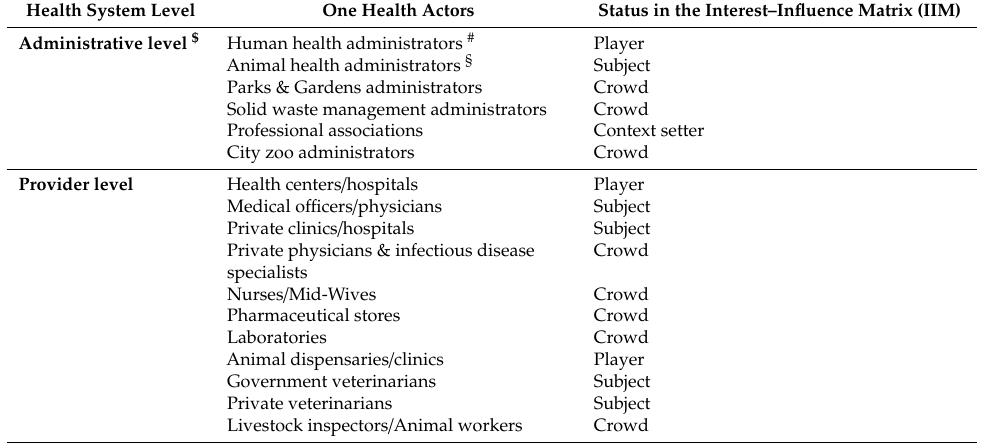
Table 1. OH actors for zoonotic disease prevention and control in Ahmedabad, India segregated by level of action and with status in the interest–influence